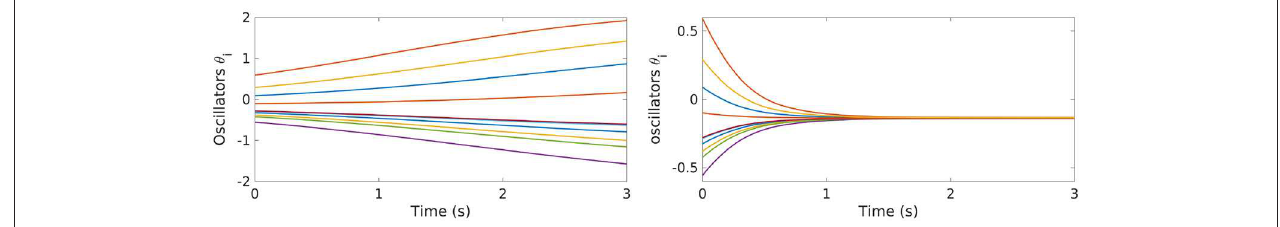
FIGURE 6 | Evolution of the uncontrolled (left) and controlled (right) dynamics of the Kuramoto model [Equation (5)] with N